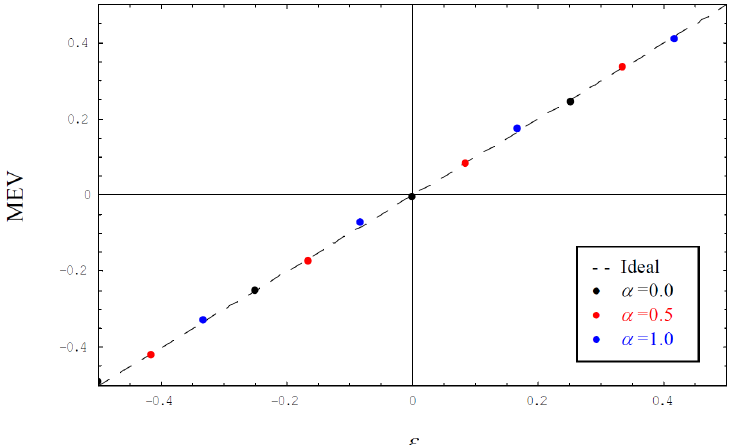
Figure 3. Mean estimator value (MEV) for timing recovery using SRC shapes (matched filter (MF) receiver).